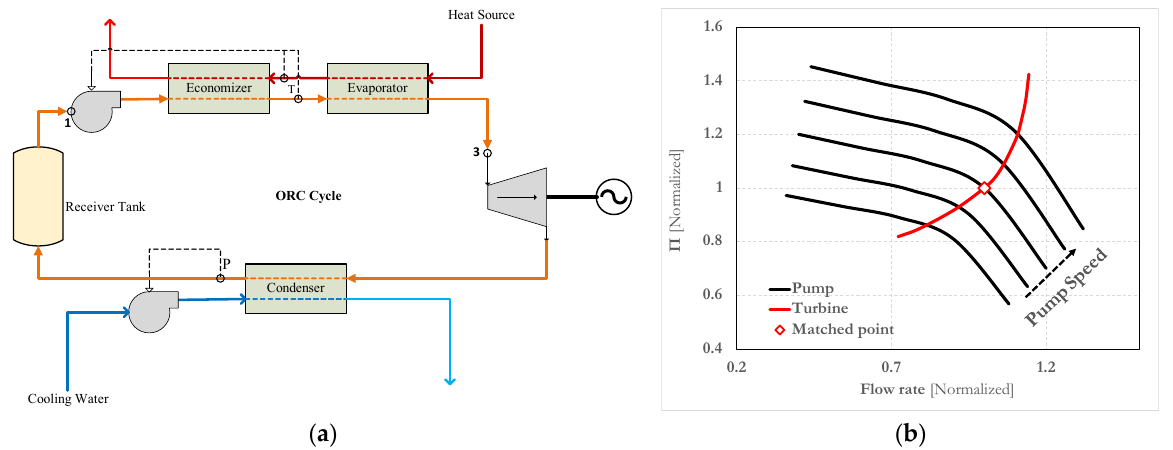
Figure 4. ORC sliding pressure control logic: ( a ) Flow-control diagram; ( b ) Matching criteria.